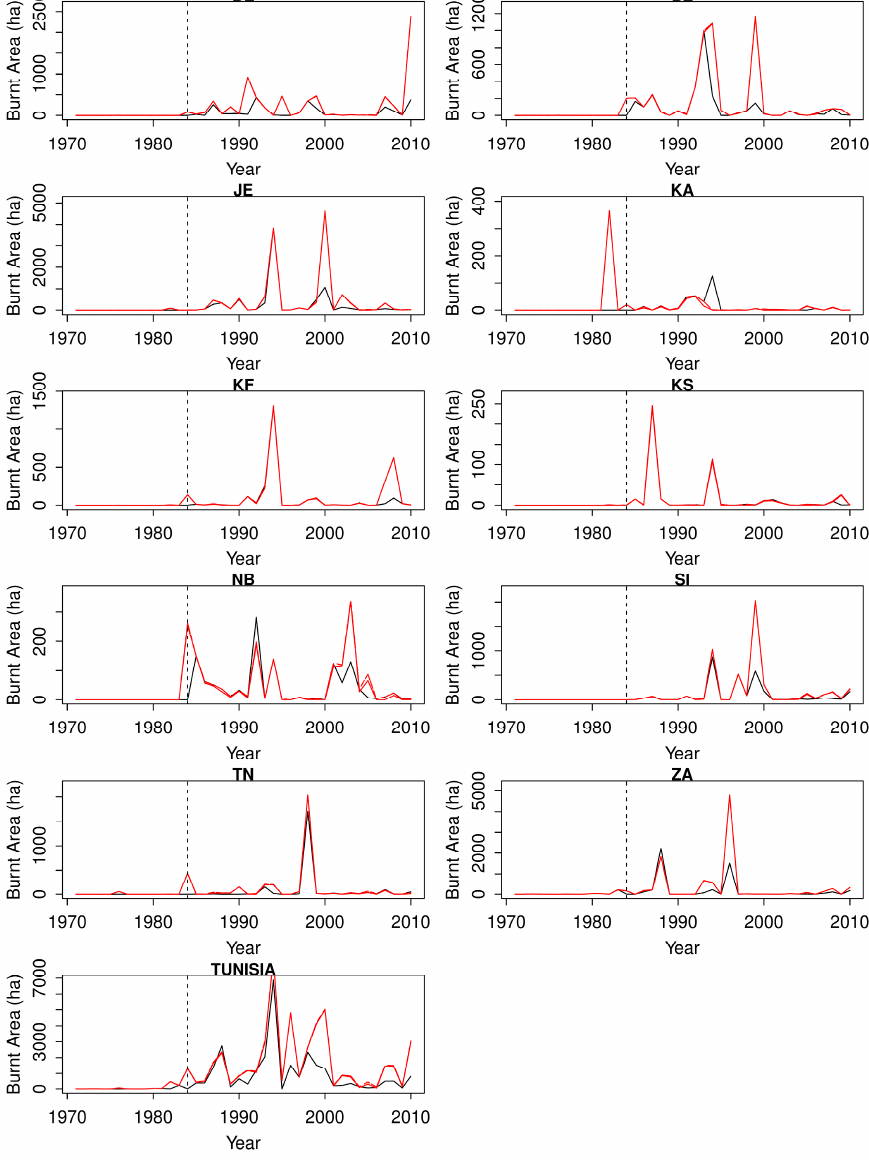
Figure 9. Yearly ( X -axis) burned area ( Y -axis in ha) for each gouvernorat and Tunisia for the 1971–2010 period. The dotted line represents the year 1985, the year before which burned area is not reliable due to missing fire records in the digital DGF database. The black line represents the official DGF burned area, and the red line represents the corrected burned area COR.